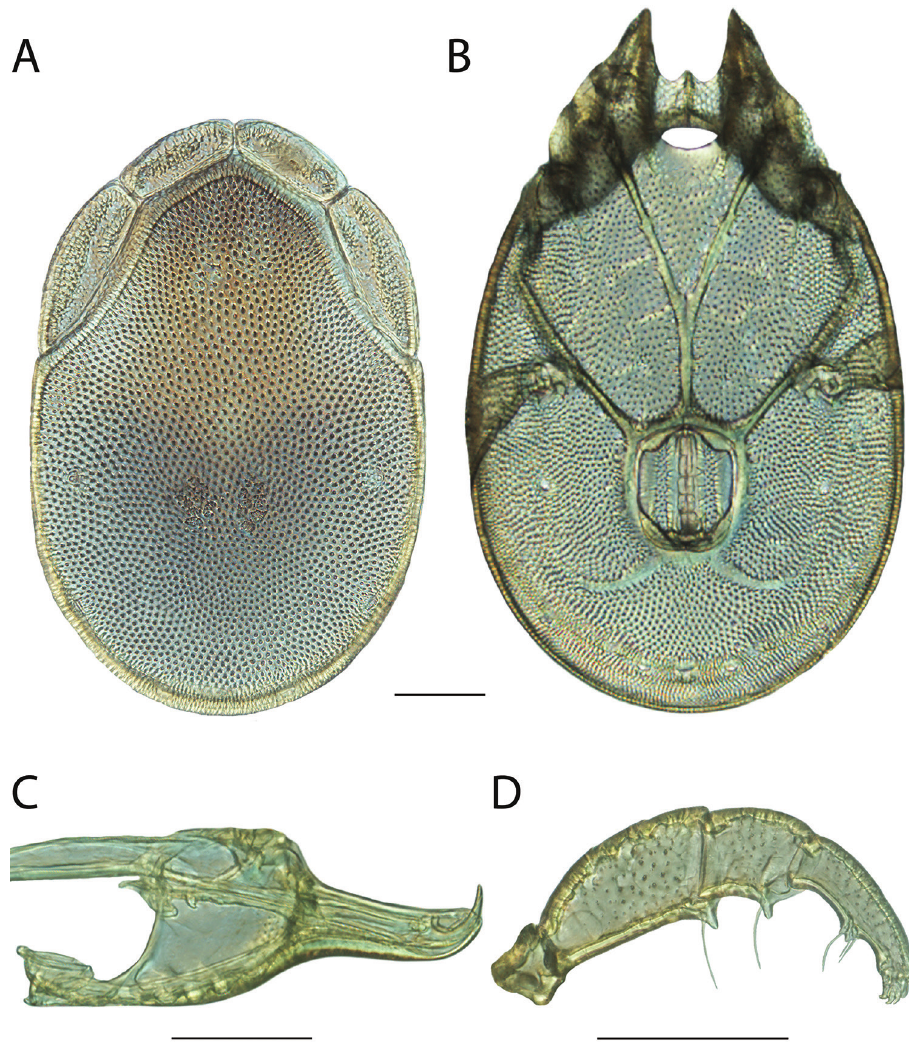
Figure 269. Torrenticola ventura male: A dorsal plates B venter (legs removed) C subcapitulum D pedipalp (setae not accurately depicted). Scale = 100